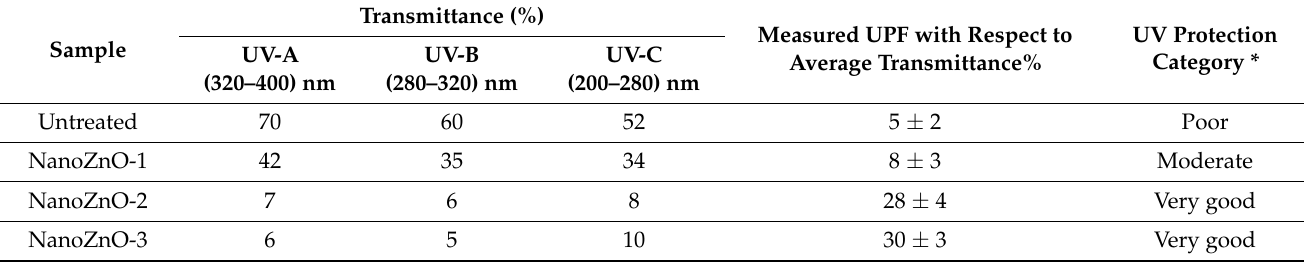
Table 1. Average UV transmittance (%) of different wavelengths with UPF